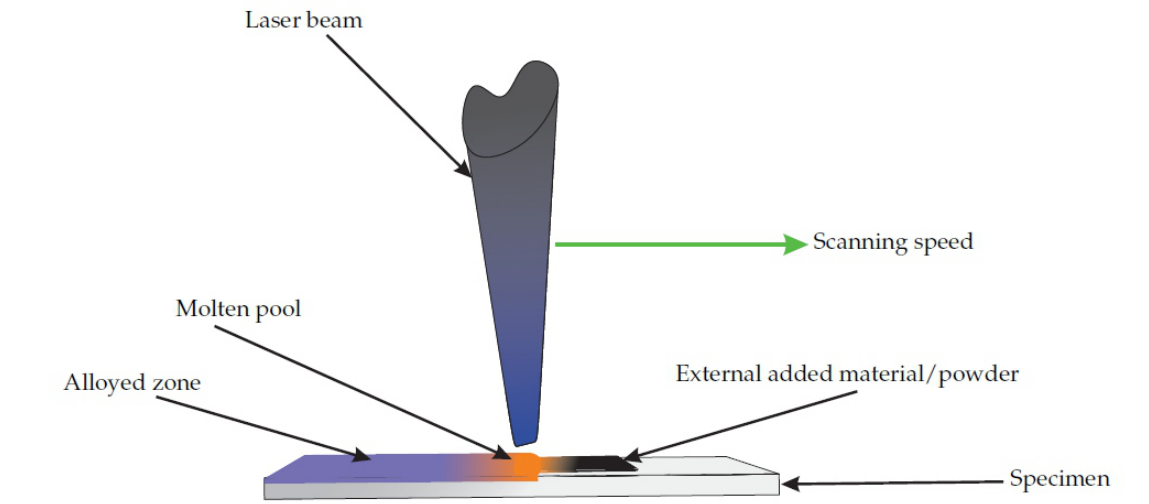
Figure 1. Schematic of laser